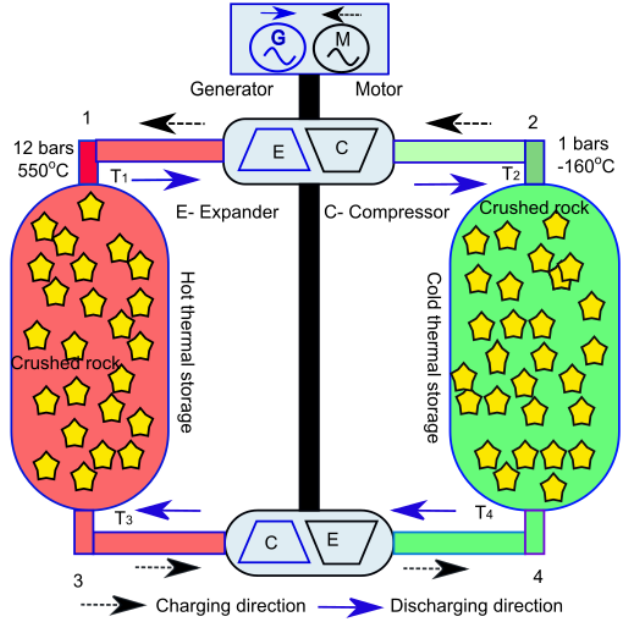
Figure 2. Schematic diagram of